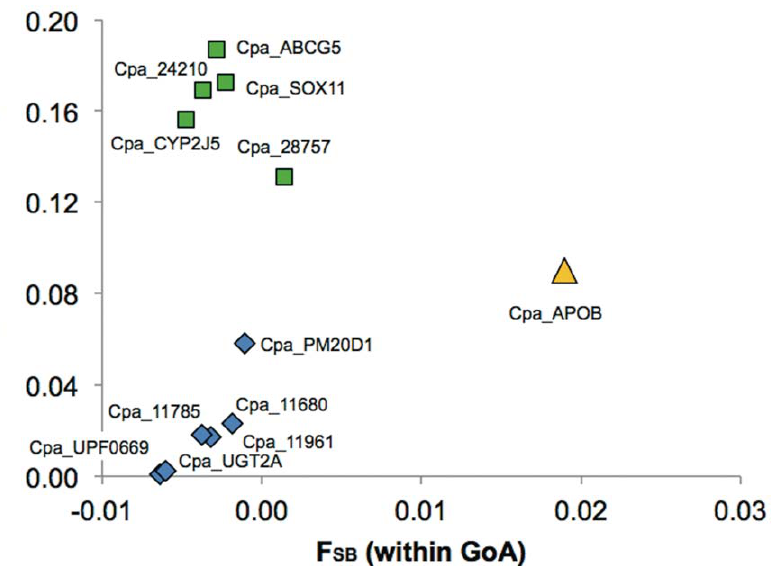
Figure 5. Variance components from a locus-by-locus AMOVA. Five loci (green) showed differentiation between the two ocean basins (high F BT ), while a single locus (yellow) significantly differentiated between Prince William Sound and Kodiak Island within the Gulf of Alaska (high F SB , yellow).